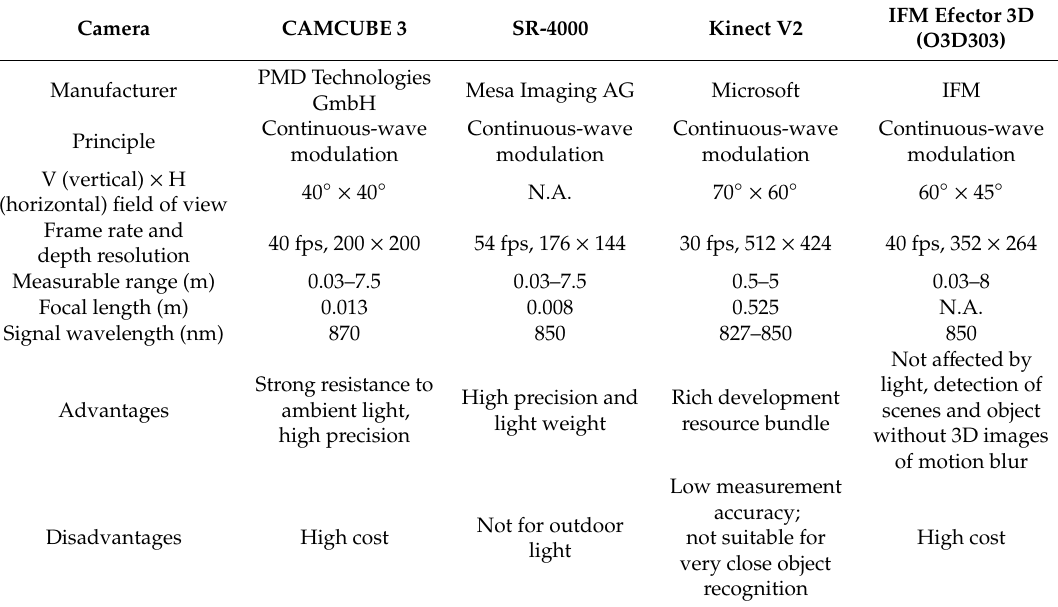
Table 4. Depth camera comparison based on time of flight